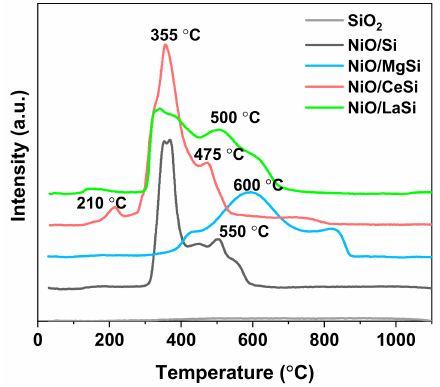
Figure 4. TPR profiles of the Ni/Oxide-SiO 2